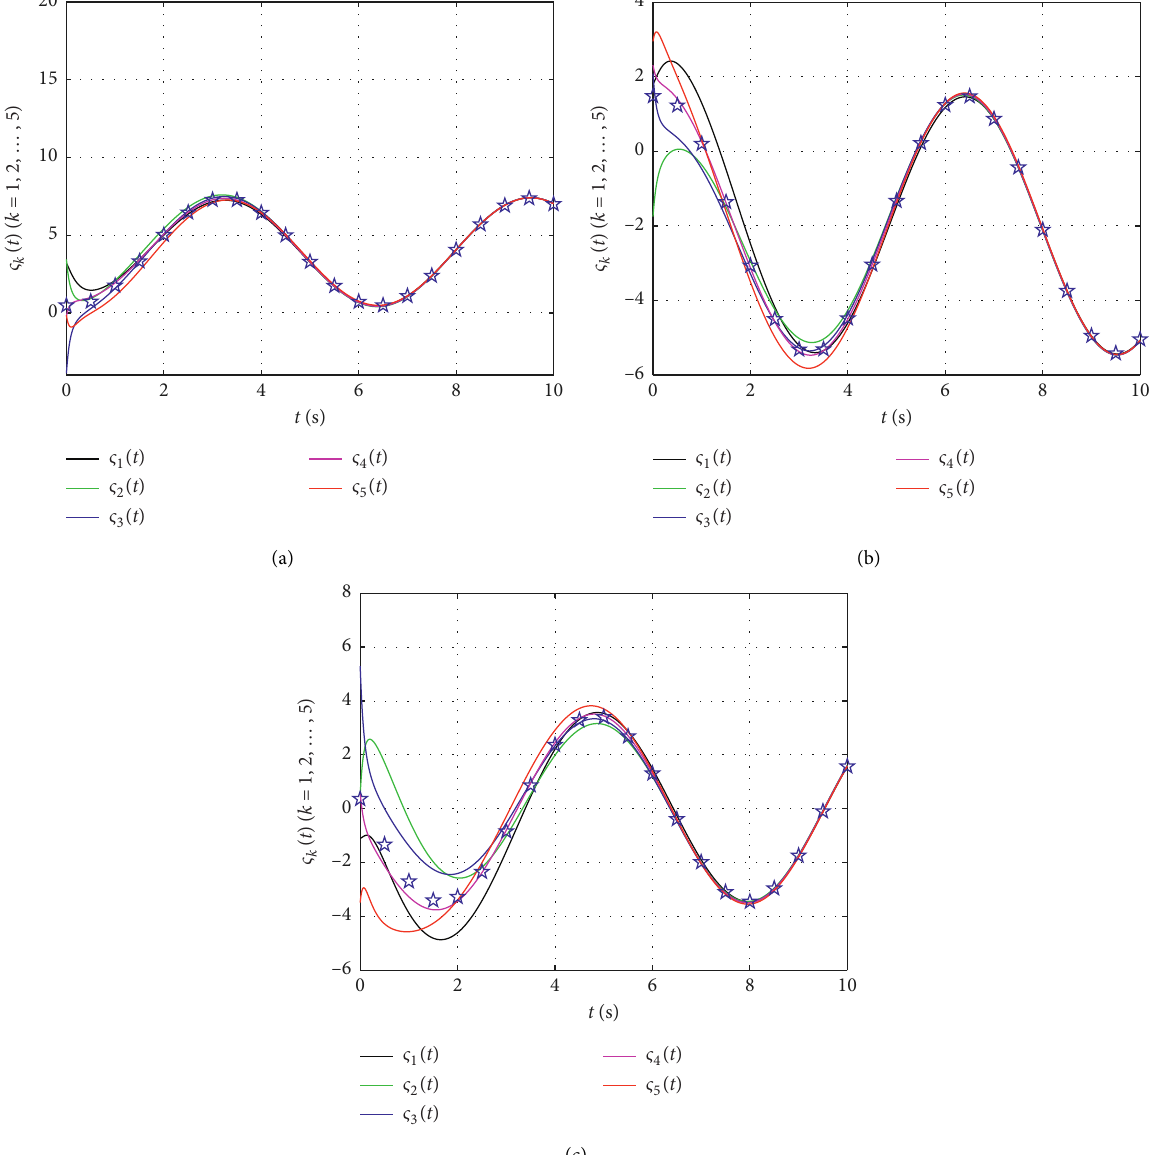
Figure 2: Trajectories of ς